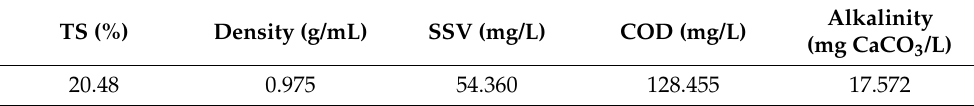
Table 1. Physicochemical properties of the analyzed